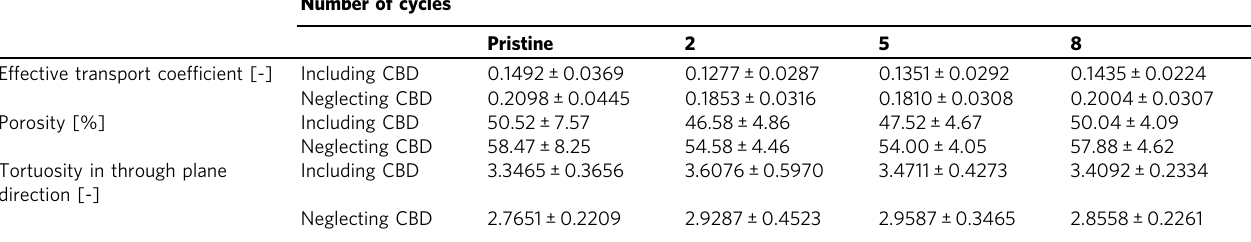
Table 2 Parameters pertaining to lithium transport in pore space. Number of cycles